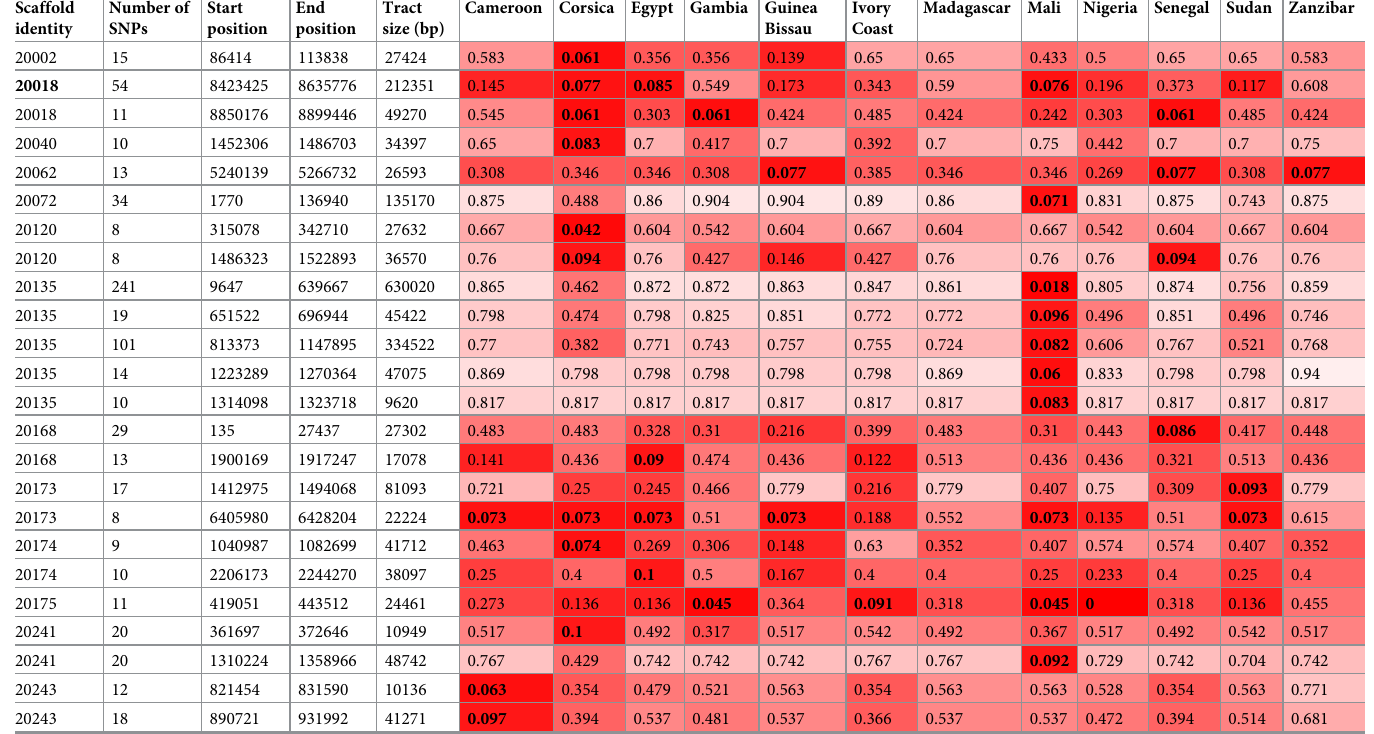
Table 2. Characteristics of the 24 S . bovis -like genomic tracts detected in at least one S . haematobium isolate and Dxy values computed between each S . haemato- bium isolate and all the S . bovis isolates within each of these 24 S . bovis -like genomic tracts. The scaffold 020018 in bold and framed in the table contains the S . bovis - like Invadolysin gene (Fig 4). Red coloration levels reflect small (dark red) to high (light red) Dxy values. Extreme low Dxy values (i.e. < 0.102) are in